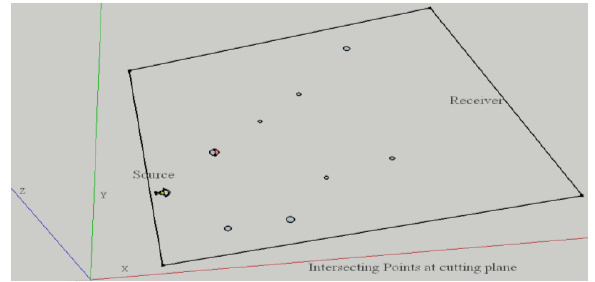
Figure 6. Cutting plane technique to determine potential points of diffraction around sides (cutting plane  X-Z plane)